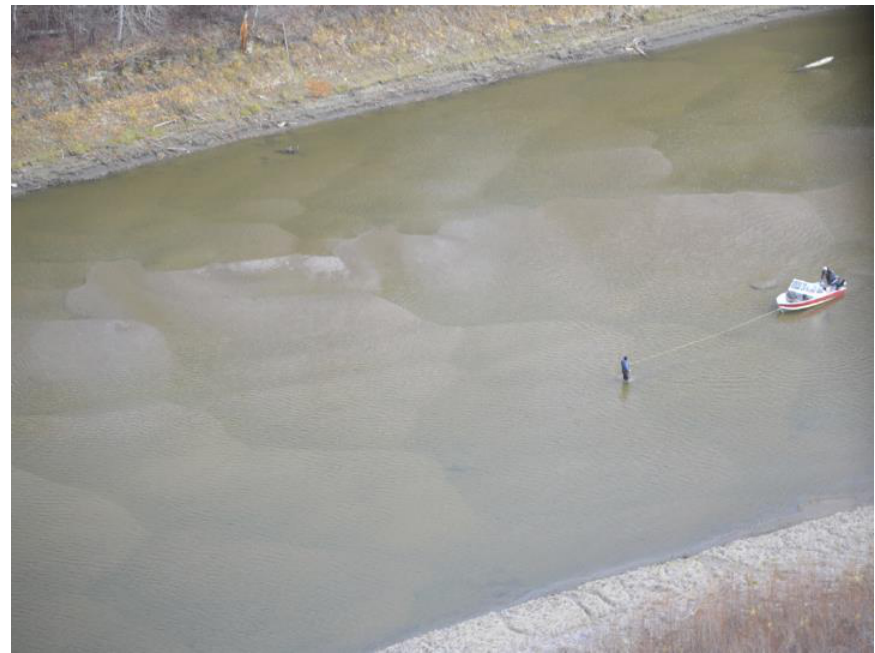
Figure 4. Picture of Indigenous People disembarked and pulling their boat due to extreme low- flow/shallow depth (appears to be ~knee deep) on the Embarras River divergence from the Athabasca River on 14 October 2015 (328 m 3 s −1 ; week 41). Reproduced with permission from and photo credited to Mr. Bruce Maclean.